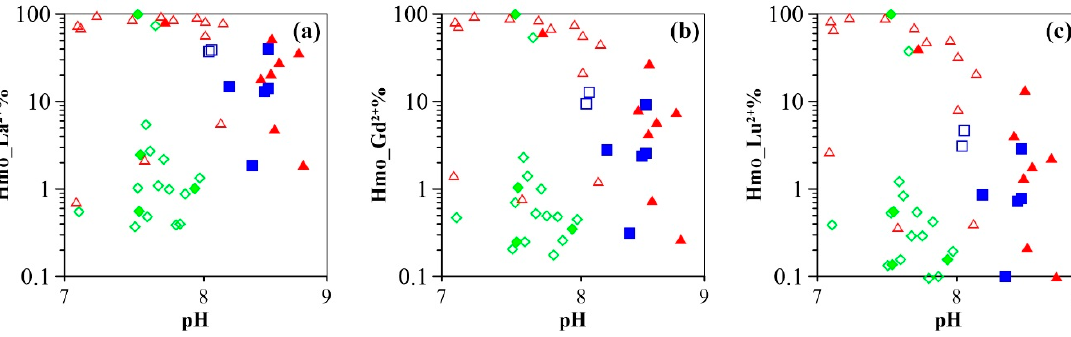
Figure 9. Proportion of La ( a ), Gd ( b ), and Lu ( c ) binding with HMO as a function of pH.